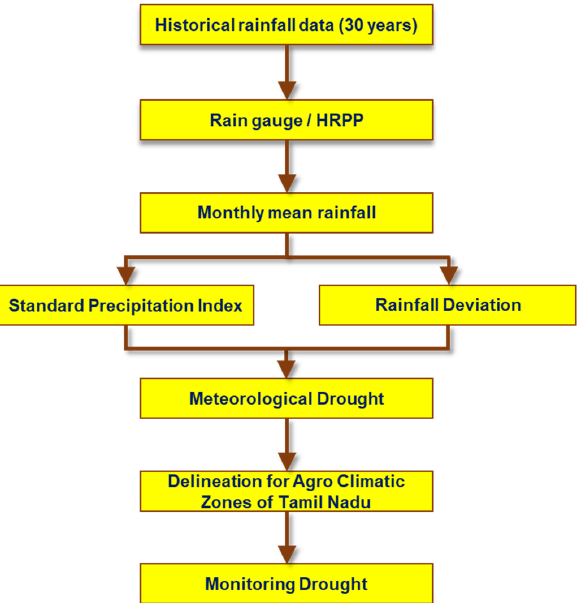
Figure 4. Flow diagram showing the development of drought monitoring